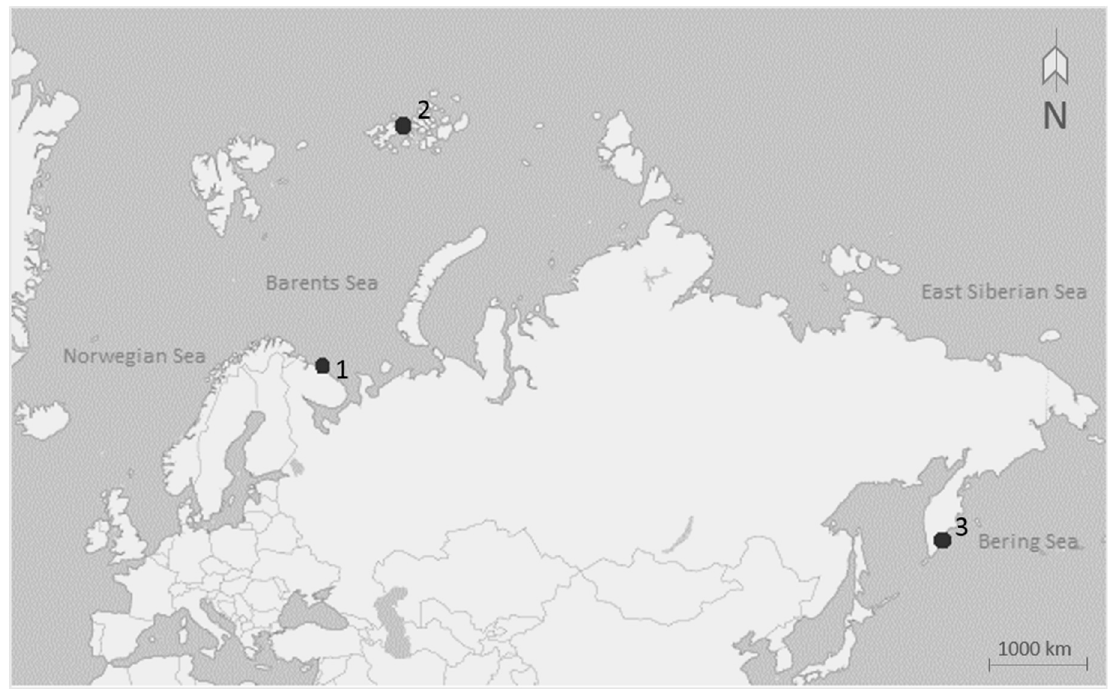
Figure 1. Map showing points of sample collection: (1) the coast of the Kola Peninsula 69° N, 36° W, (2) Franz Josef Land 80° N, 57° W, and (3) East Kamchatka, Starichkov Island 52° N, 158° E.